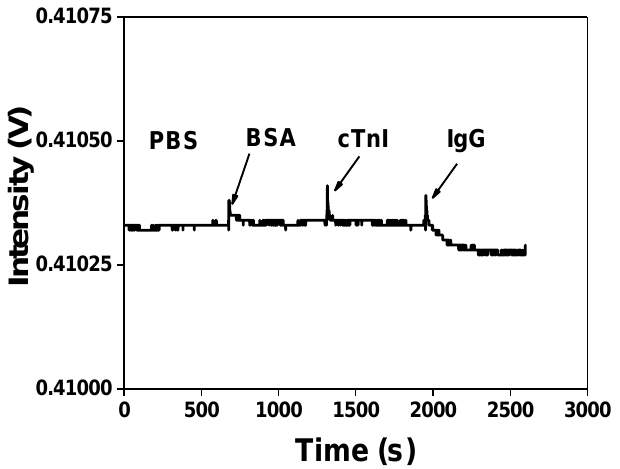
Figure 6. Non-specific adsorption tests. The sensorgram of IgG antibody-functionalized AuNPs–GO FOPPR sensor in response to bovine serum albumin (BSA, 1.0 × 10 – 6 g/mL), cardiac troponin I (cTnI, 1.0 × 10 – 6 g/mL) and IgG (1.0 × 10 – 10 g/mL) solutions.